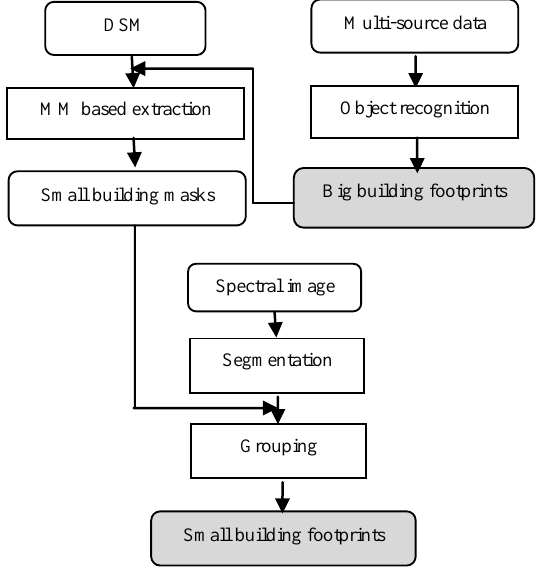
Figure 1 The general technique illustration It respectively generates the small building footprints and the big building footprints through two algorithm branches. The